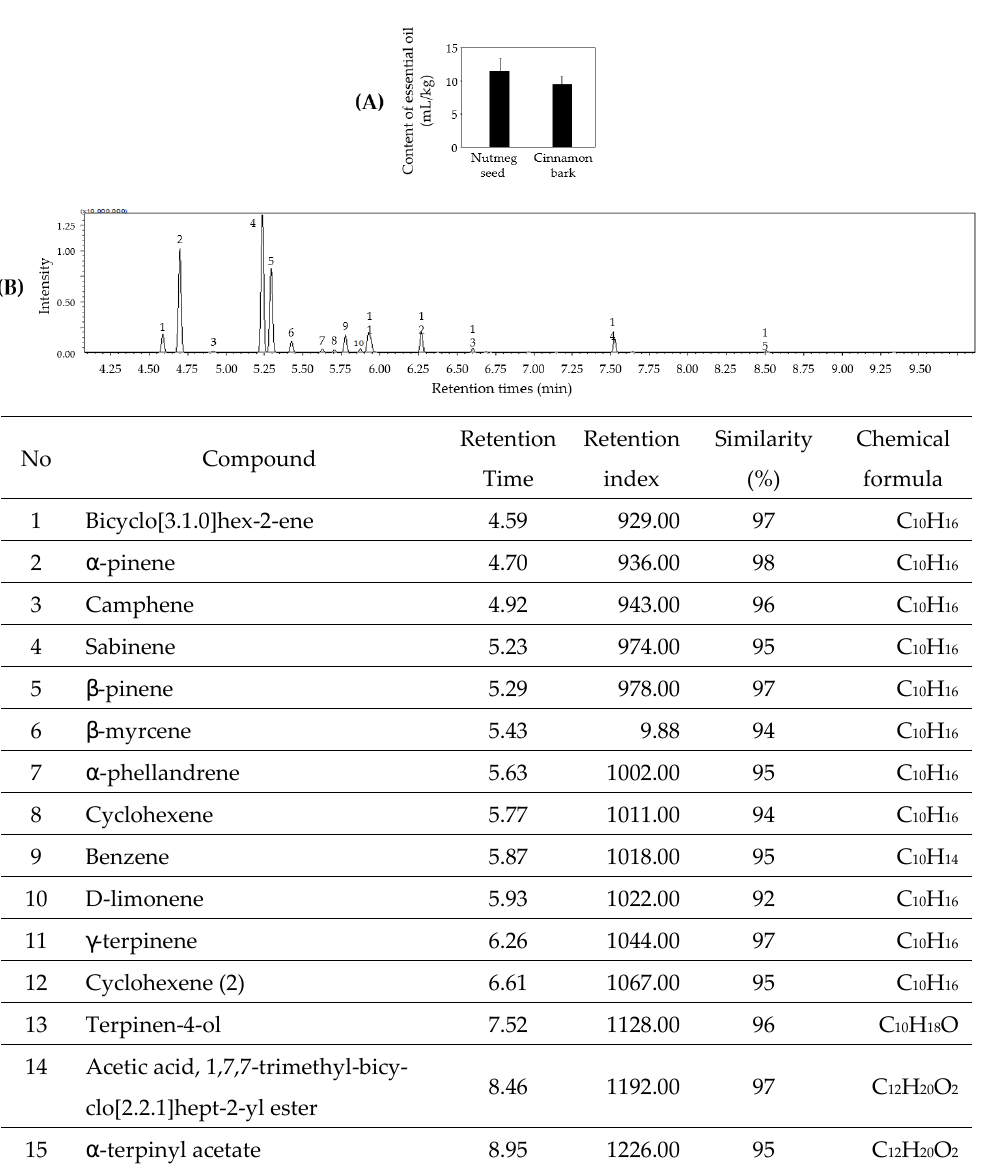
Figure 5. Nutmeg seeds essential oils content and components. ( A ) Essential oil content of nutmeg seed and cinnamon bark. ( B ) Essential oil component of nutmeg seed analyzed by GC-MS.